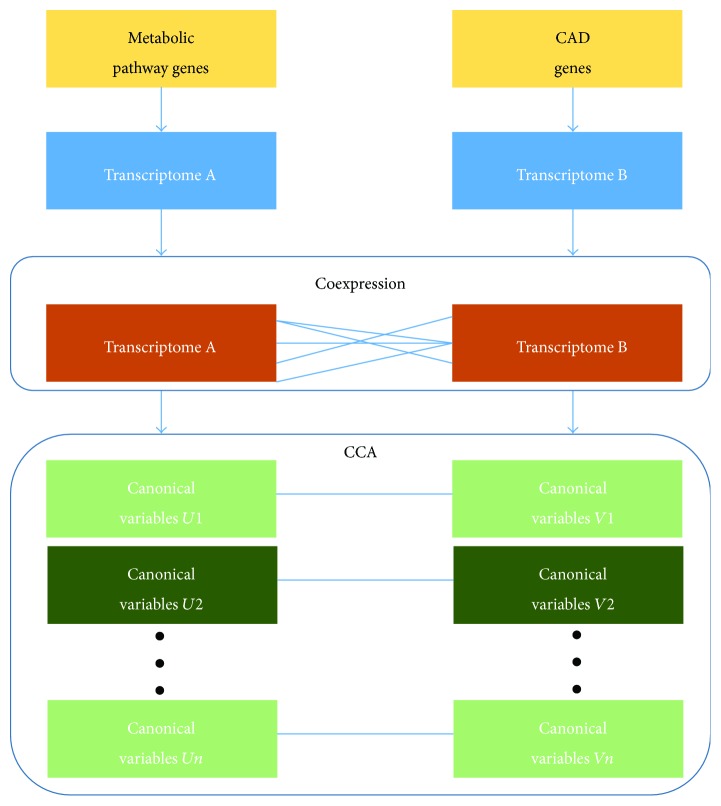
Strategy of study for the canonical correlation analysis. Collection of CAD genes and metabolic pathway genes; construction of the coexpression network among individual CAD and metabolic pathway genes; performance of CCA; and analysis of canonical variables.